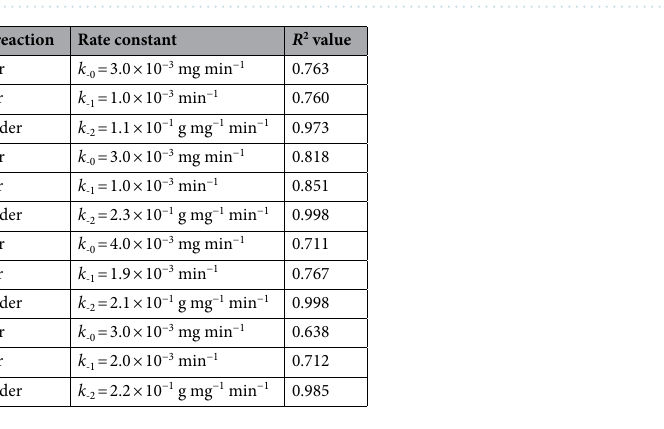
Table 5. Rate constants and R 2 values obtained by modelling the desorption of diazinon and dichlorvos from the CDA and starch surfaces into water at pH 7.0 and 27